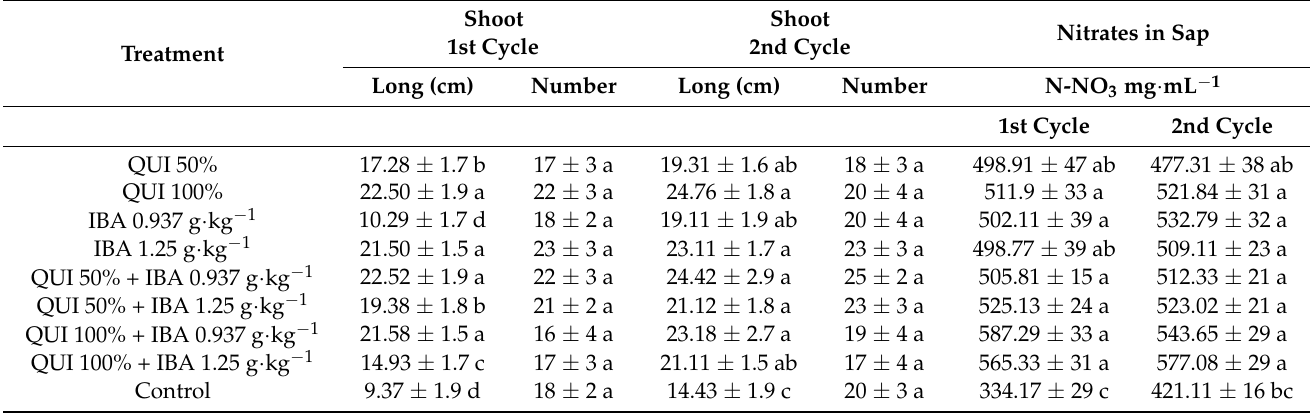
Table 5. Root length, fresh and dry root weight, and number and length of shoots generated from cuttings of S. bigelovii , produced in the Altar desert, Sonora.